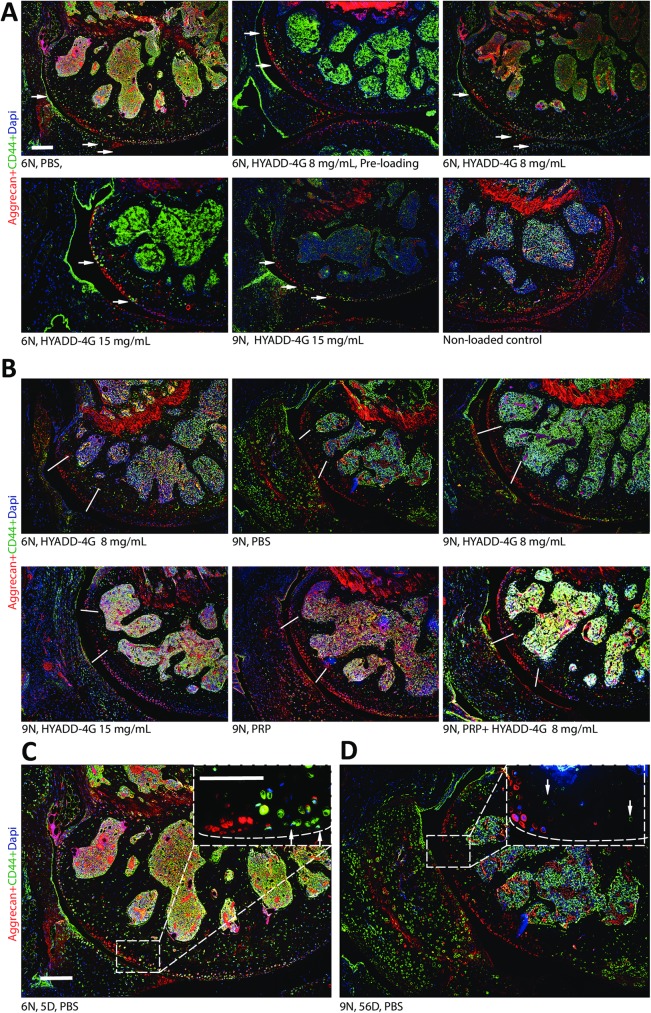
CD44 and aggrecan staining.At day 5, CD44 (green) was mainly seen in the calcified zone of articular cartilage in control knees with only a few CD44-positive signals around hypertrophic chondrocytes (A). CD44 signals were not found at the site of cartilage injury, albeit higher signals were discovered in the chondrocytes immediately around the injured zone (white arrows). There was no difference in the pattern of CD44 expression between different treatment groups. Aggrecan staining (red) was found around the chondrocytes in the intact area and in the lacuna left by the apoptotic chondrocytes in the injured area. Bar = 100 μm. At day 56, CD44 in the loaded knees, same as non-loaded control knees, was mainly seen in the calcified zone of articular cartilage with only a few CD44-positive signals around hypertrophic chondrocytes. No substantial CD44 signals were found in the chondrocytes immediately around the injured zone as day 5. There was no difference in the pattern of CD44 expression between different treatment groups. Aggrecan staining (red) was much weaker in the injured region but remain the same in the intact area of the loaded cartilage. White bars indicate the injured areas (B). Representative images of day 5 (C) and day 56 (D) of injured knees. White dotted boxes indicate the enlarged area. The white arrows in C indicate the higher CD44 signals in the chondrocytes immediately around the injured zone at day 5 while the white arrows in D show the expression of CD44 in the hypertrophic chondrocytes in both loaded and non-loaded knees at day 56. Also, low intensity of aggrecan signal in the injured region at day 56 was noticed. Dotted lines indicate the joint surface. PBS = phosphate buffered saline, PRP = platelet-rich plasma.